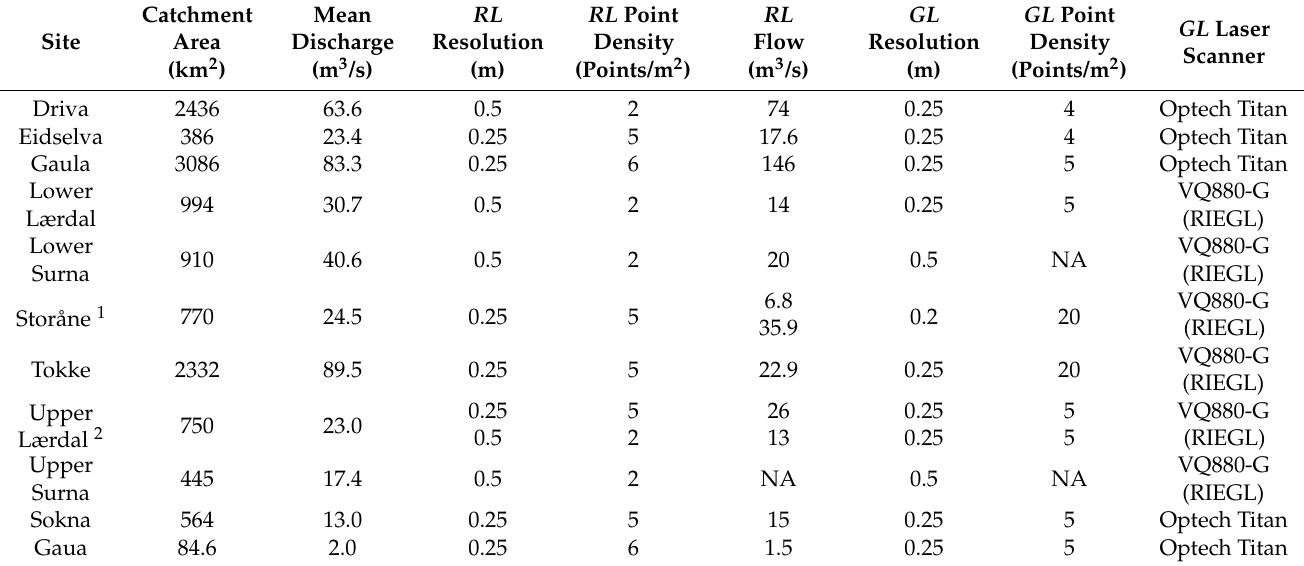
Table 1. General descriptions of the sites’ sizes and the LiDAR data properties.